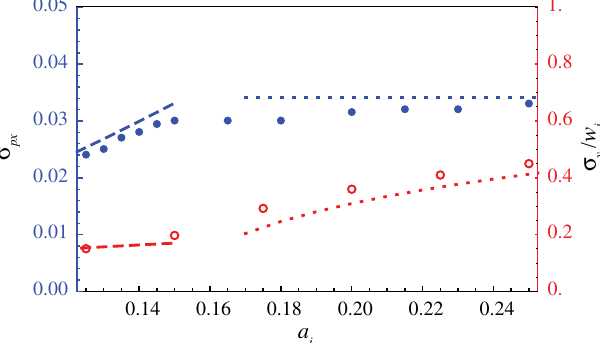
FIG. 6. The rms transverse momentum of the ionized electron distribution, after the ionization laser pulse, σ (blue points, left p x verticalaxis) and the rms sizeofthetransversespatial distribution of =w ionizedelectronsnormalizedtothelaserspotsize σ (redcircles, y i right vertical axis) obtained from PIC simulations. The ionization ¼ 0 . 4 μ m, and FWHM duration 16 fs, ionizing a laser has λ i ¼ 230 eV), in a background krypton gas, Kr 8 þ → Kr 9 þ ( U I plasma of density 2 × 10 17 cm − 3 . The blue dashed curve is Eq. (14), and the blue dotted line is the saturated value Eq. (17). The dashed red line is Eq. (15), and the red dotted line is Eq. ¼ 0 . 14 and for (a) a g i ¼ 32 . L i i